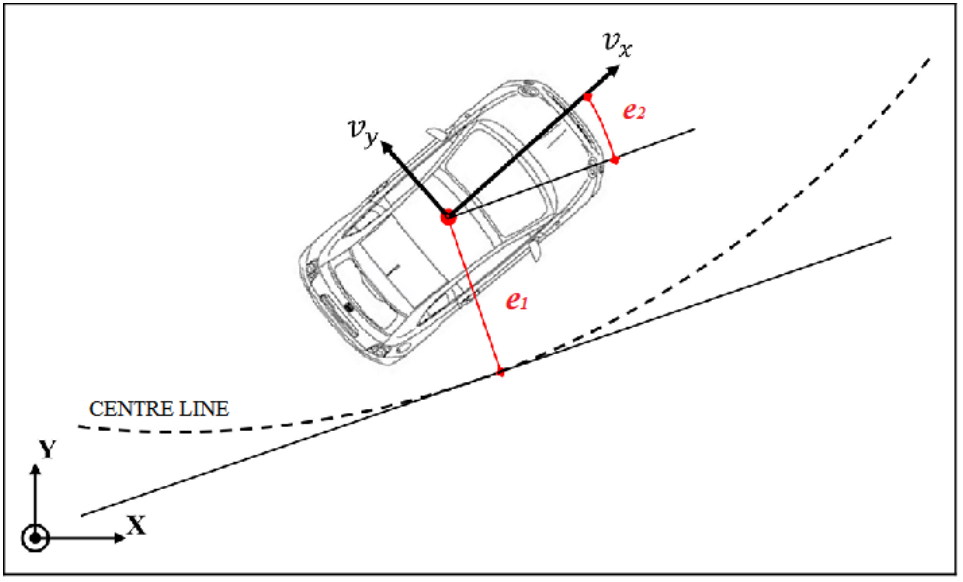
Figure 1. Errors with respect to the